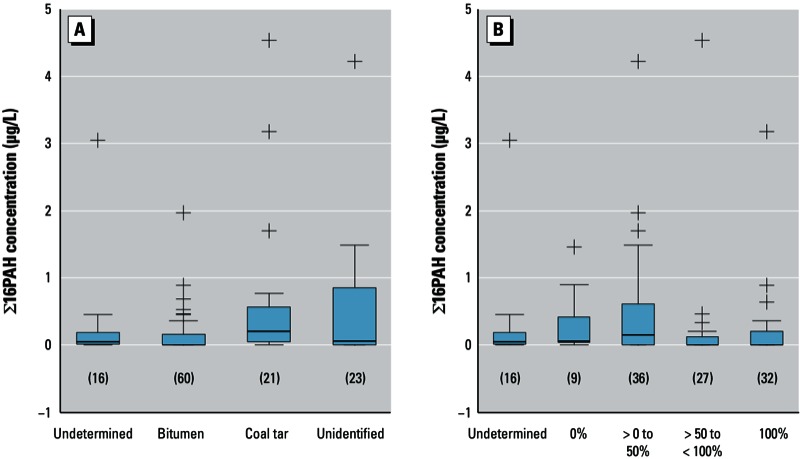
Box and whisker plot of PAH concentrations in repair 1 samples (collected 2–4 hr after a water main segment was removed upstream of the sampling location) by (A) type of coating and (B) percent of coating coverage. Numbers in parentheses indicate the number of samples. Boxes represent the 25th–75th percentiles; horizontal lines within boxes represent medians; whiskers extend 1.5 times the length of the interquartile range above and below the 75th and 25th percentiles; and outliers are represented as “+” symbols.